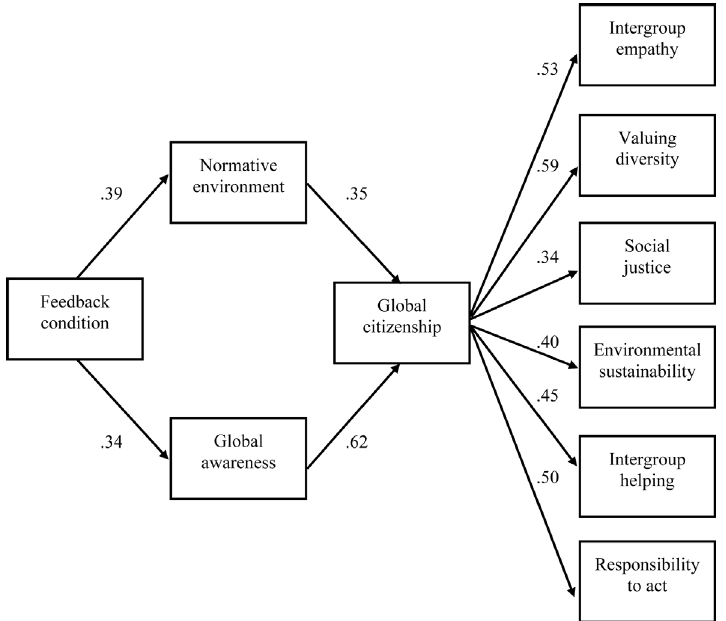
Figure 2: Influence of perceived world knowledge manipulation (-1 = low score, 0 = no feedback, 1 = high score) on model of antecedents and outcomes of global citizenship identification – all paths significant at p <